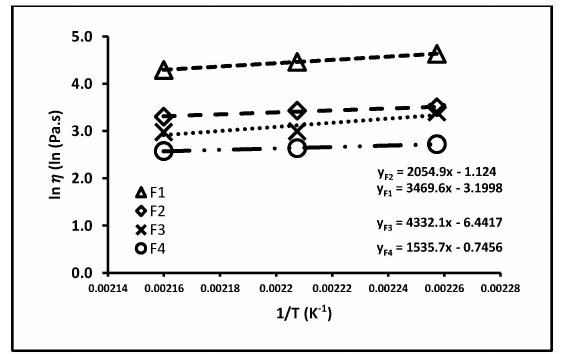
Figure 7. Dependence of shear viscosity with temperature for different feedstock formulations.